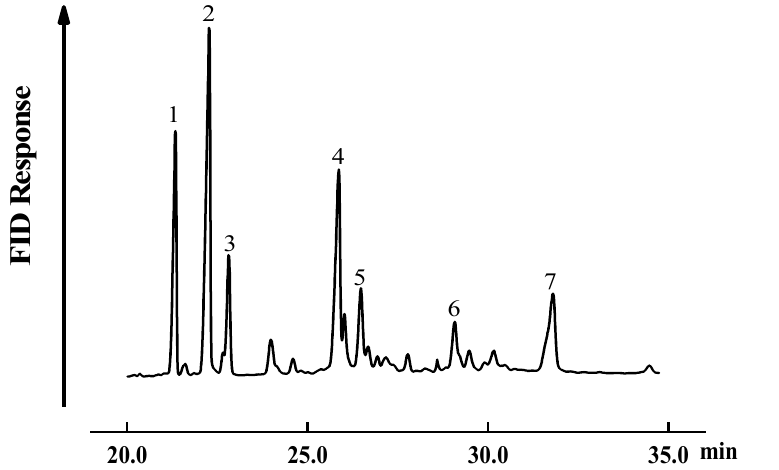
Figure 5. Gas chromatogram analysis of soybean germ phytosterols’ oxidation products (note: 1, cholesterol; 2 and 3, 7 α ( β ) ‐ hydroxy; 4 and 5, 5 α ( β ), 6 α ( β ) ‐ epoxy; 6, triol; 7, 7 ‐ keto).